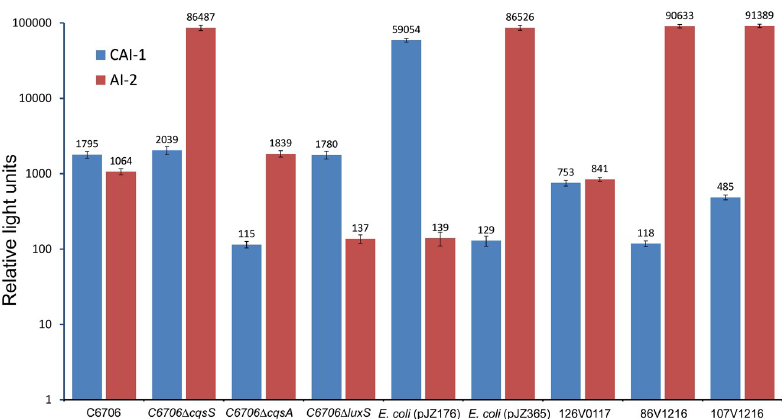
Fig 1. Activity of autoinducers CAI-1 and AI-2 produced by different strains as estimated using bioluminescence reporter assays, and expressed as relative light units (RLU, see text for details). Recombinant E . coli strains carrying plasmids pJZ176 and pJZ365 produce CAI-1 and AI-2 respectively in their culture supernatants. Strains 126V0117, 86V1216 and 107V1216 are environmental V . cholerae non-O1 non-O139 isolates. Strain C6706 is a laboratory strain of V . cholerae O1, C6706 Δ cqsS carry deletions of the gene encoding the receptor for CAI-1, whereas C6706 Δ cqsA and C6706 Δ luxS carry deletions of genes for biosynthesis of CAI-1 and AI-2 respectively. chain. Most other gene products of the quorum sensing pathway were found to be similar in all strains analyzed, except that the cqsA gene encoding CAI-1 synthase was absent in the non- O1 non-O139 strain 86V1216, whereas in strain 107V1216 the predicted protein product of cqsA gene had replacement in two amino acids. Precisely, lysine was replaced by leucine at position 299. Whereas Lysine is a charged basic amino acid, leucine is nonpolar. Besides, tyro- sine was replaced by cysteine at position 383, and both of them are polar amino acids (Fig 2b). The hapR protein in these two non-O1 non-O139 strains were slightly altered as compared to strain C6706 (Fig 2c). Namely, alanine in position 204 was replaced by valine, and both these residues are nonpolar in nature. Notably, V . cholerae strain N16961 does not have an active hapR gene due to a natural frameshift mutation [21].